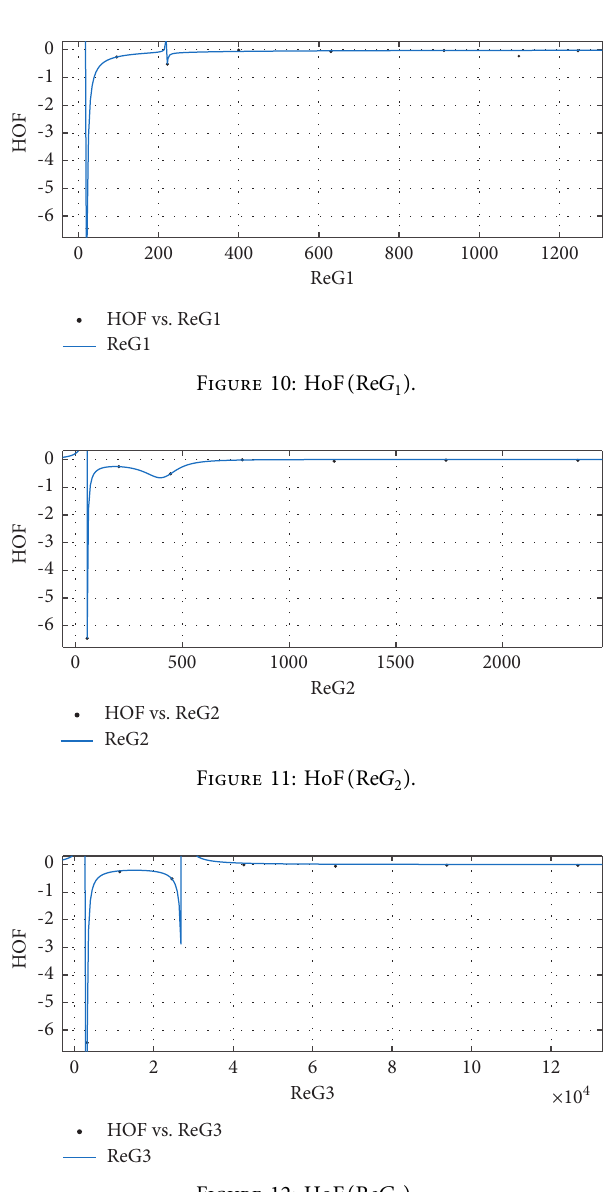
Figure 12: HoF ( Re G